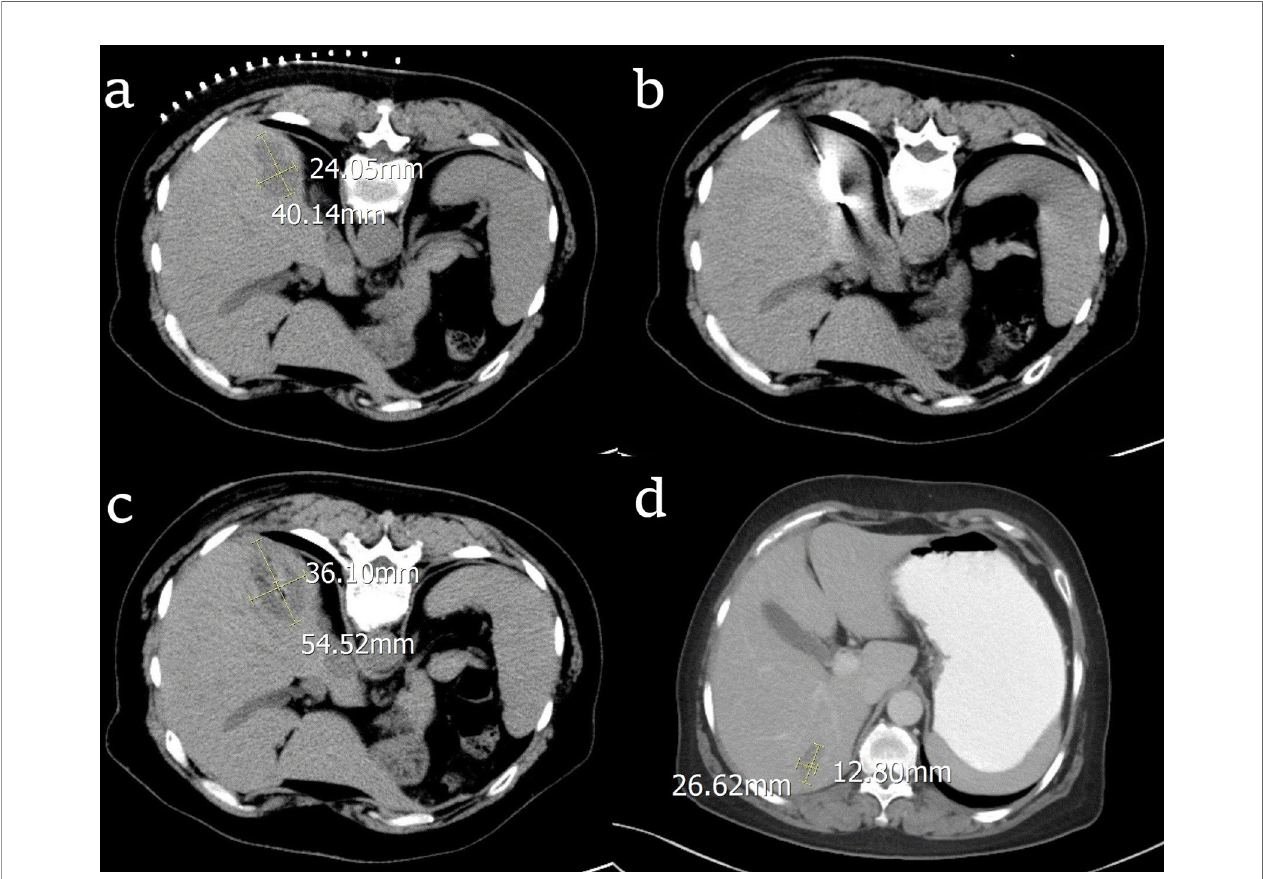
FIGURE 1 | CT images of the process of radiofrequency ablation (RFA) treatment for one patient with ovarian cancer liver metastasis (OCLM). (A) the location and diameter of the tumor before RFA; (B) the radiofrequency electrode in the center of the tumor; (C) the location and diameter of the tumor right after RFA; (D) the location and diameter of the tumor after 6 months.